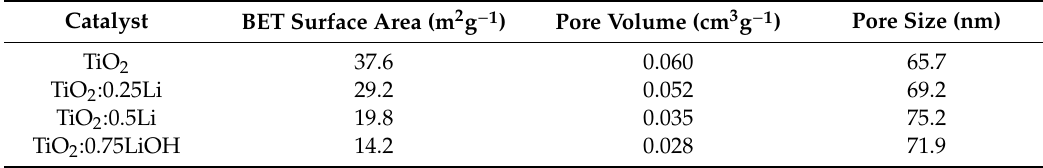
Table 2. Brunauer–Emmett–Teller (BET) results of various catalysts. Catalyst